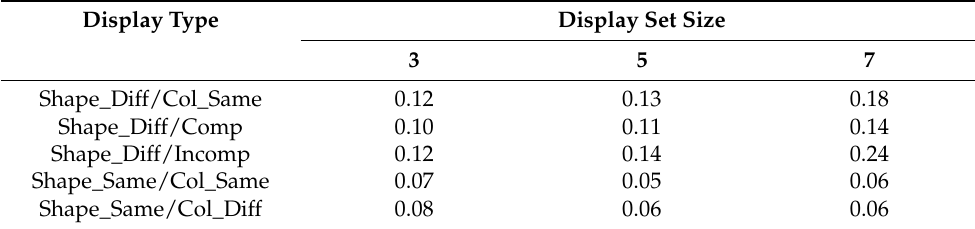
Figure 2. Graphical illustration of the mean RTs for the control conditions in Experiment 1. Error bars reflect 95% CIs as recommended by Bakeman and McArthur [14]. Table 1. Average error rates (expressed as proportions) for the conditions of interest in Experiment